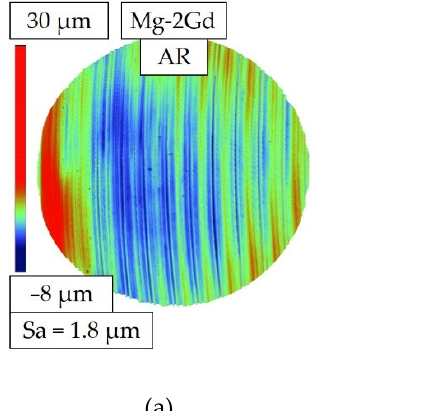
Figure 8. Topographies of the Mg-2Gd alloy as measured by white light interferometry (WLI): ( a ) Topography in as-received (AR) state with machining marks and a peak-valley difference of 38 (30 µm to −8 µm) ( b ) Topography after etching with 250 g/L HAc for 15 s in 5 mL of solution. Machining marks are still visible and the peak-valley difference of 27 µm (17 µm to −10 µm) is reduced in as compared to the AR state.